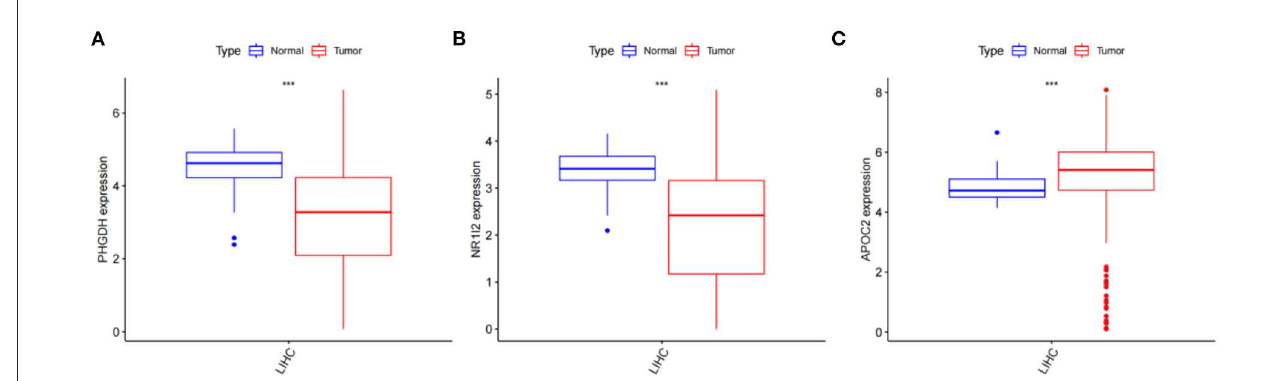
FIGURE11 Analysis of the relative expression of target genes; (A) Relative expression of PHGDH ( p < 0.001); (B) Relative expression of NR1I2 ( p < 0.001); (C) Relative expression of APOC2 ( p < 0.001).